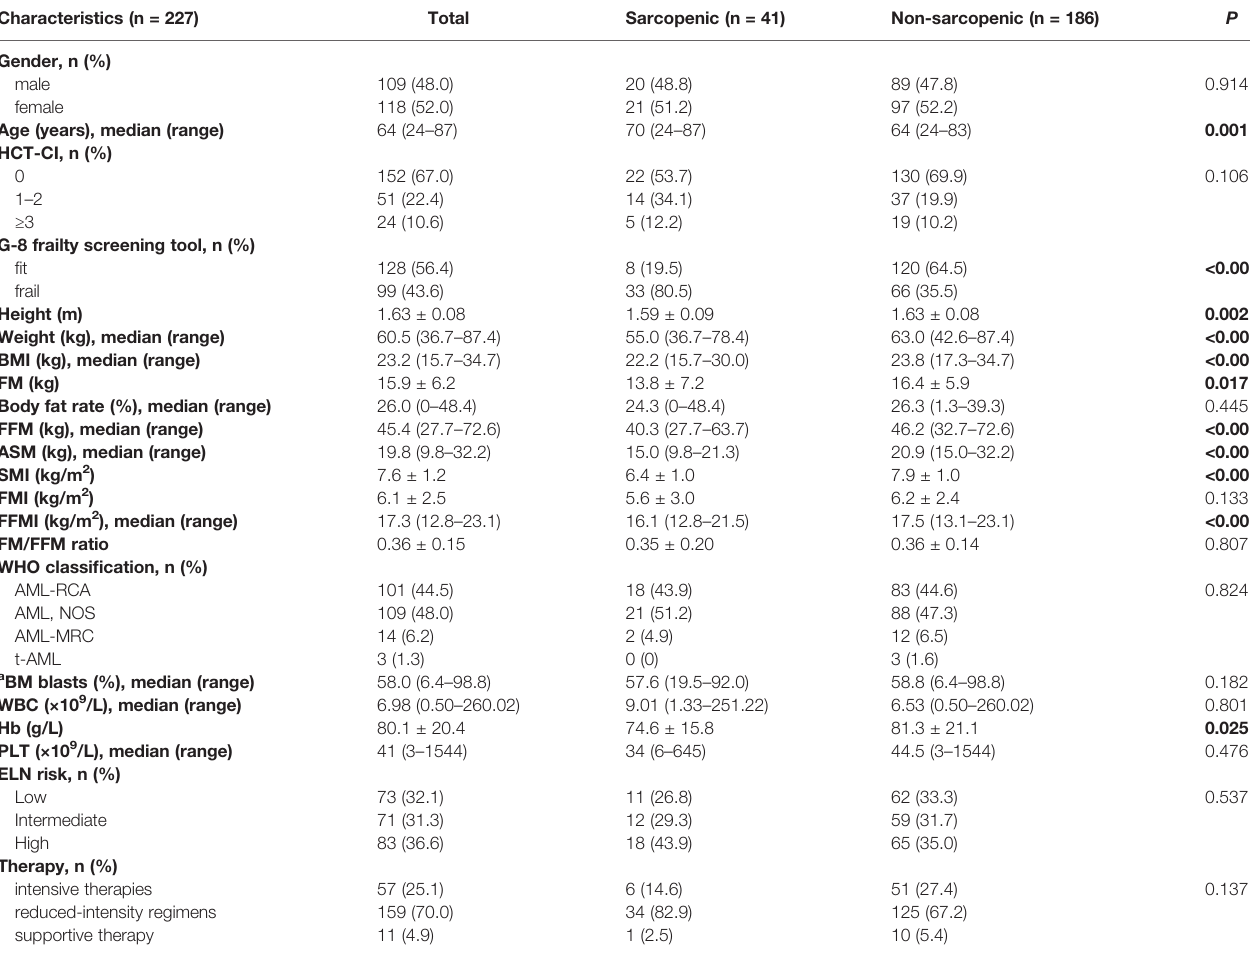
TABLE 1 | Patients ’ characteristics. Characteristics (n =